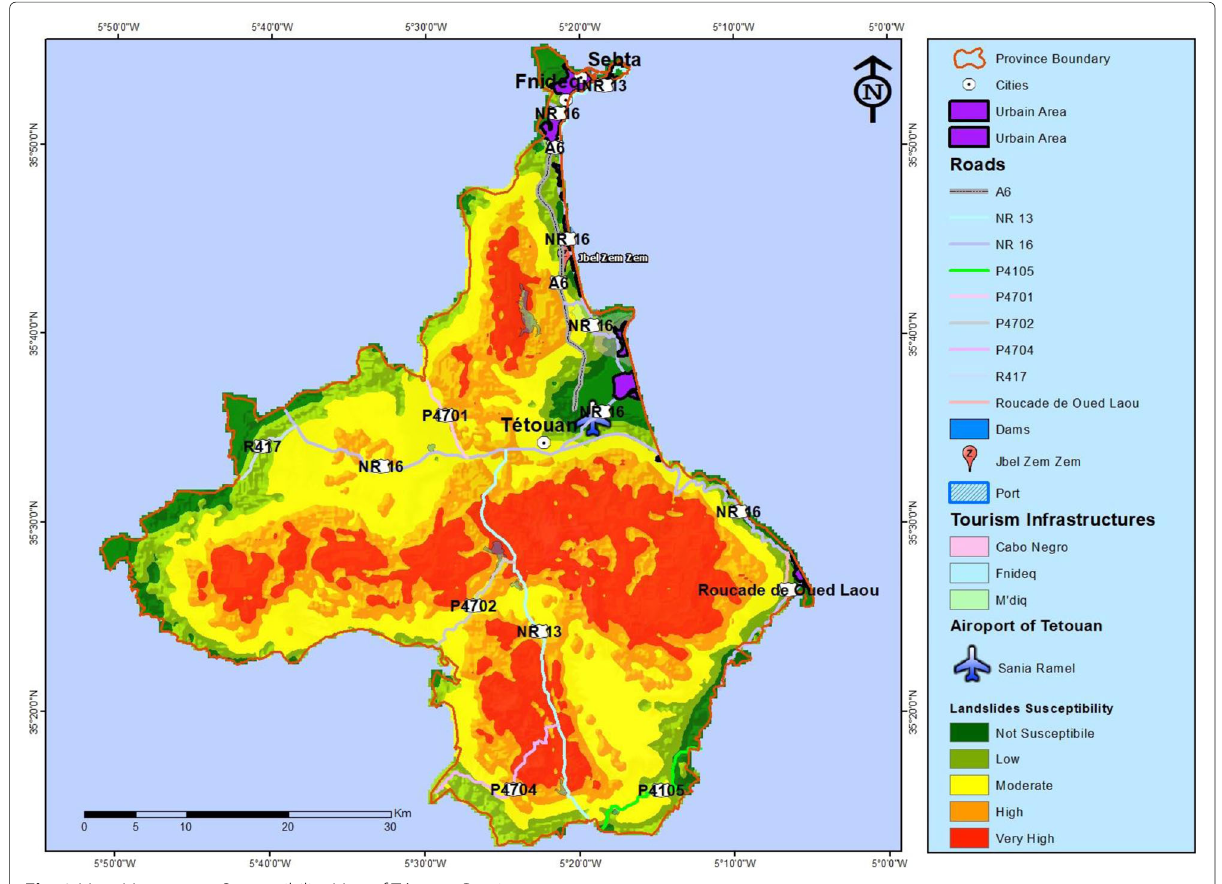
Fig. 9 Mass Movements Susceptibility Map of Tétouan